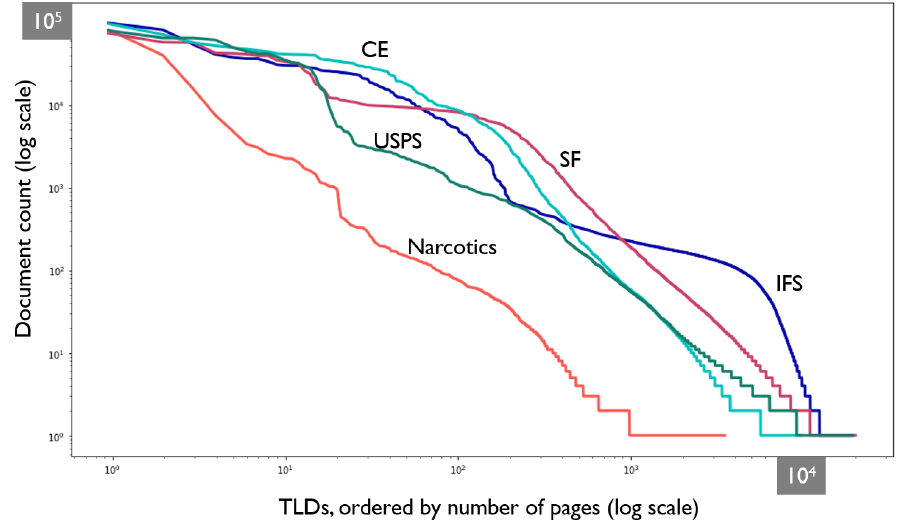
Figure 8. Document counts per TLD (Y-axis) against the ranked list of TLDs (ordered by document count on the